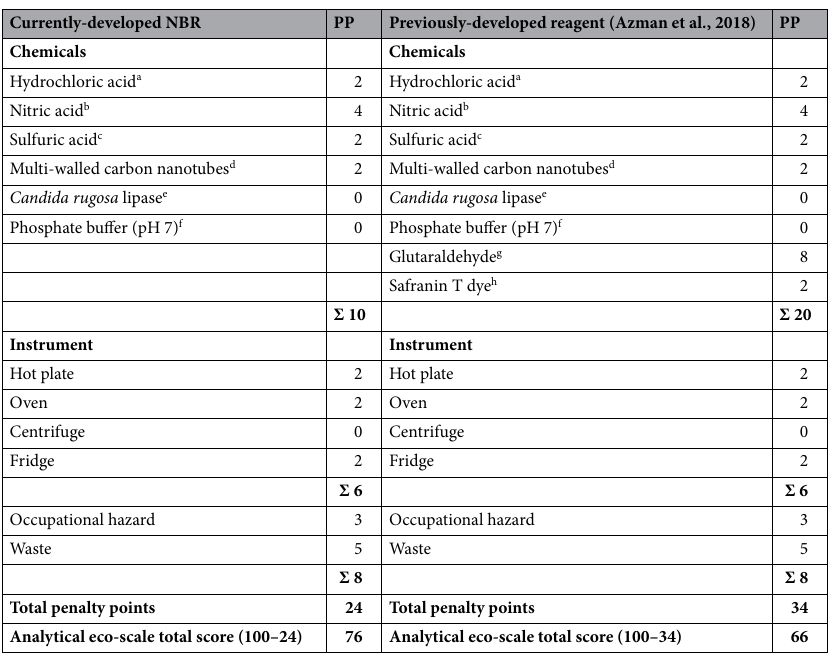
Table 3. The penalty points for preparing the NBR for fingerprint visualisation. Preparation of F-MWCNTs as described by the USains Holdings Sdn Bhd (7 M HNO 3 :H 2 SO 4 (1:1) refluxed for 3 h at 90 ℃ ). a (Merck, 2018a), b (Merck, 2020), c (Merck, 2018b), d (Sigma-Aldrich, 2020), e (Sigma-Aldrich, 2012), f (QRec, 2011), g (Sigma- Aldrich, 2019) and h (Sigma-Aldrich,